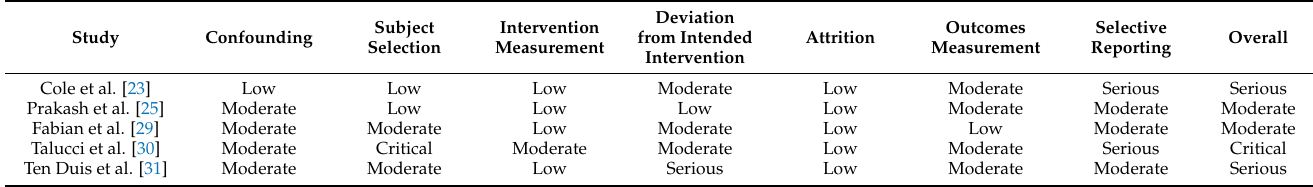
Table 1. Risk of bias for nonrandomized